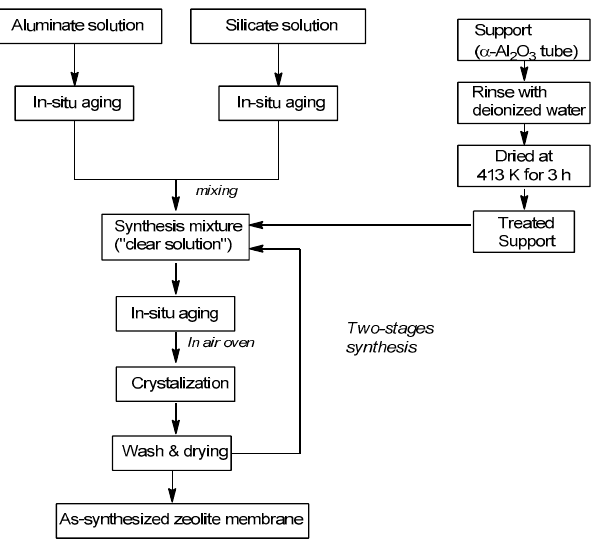
Figure 12. Flow diagram of the in-situ crystallization method for the synthesis of zeolite membranes [7]. Reproduced with permission from [7].